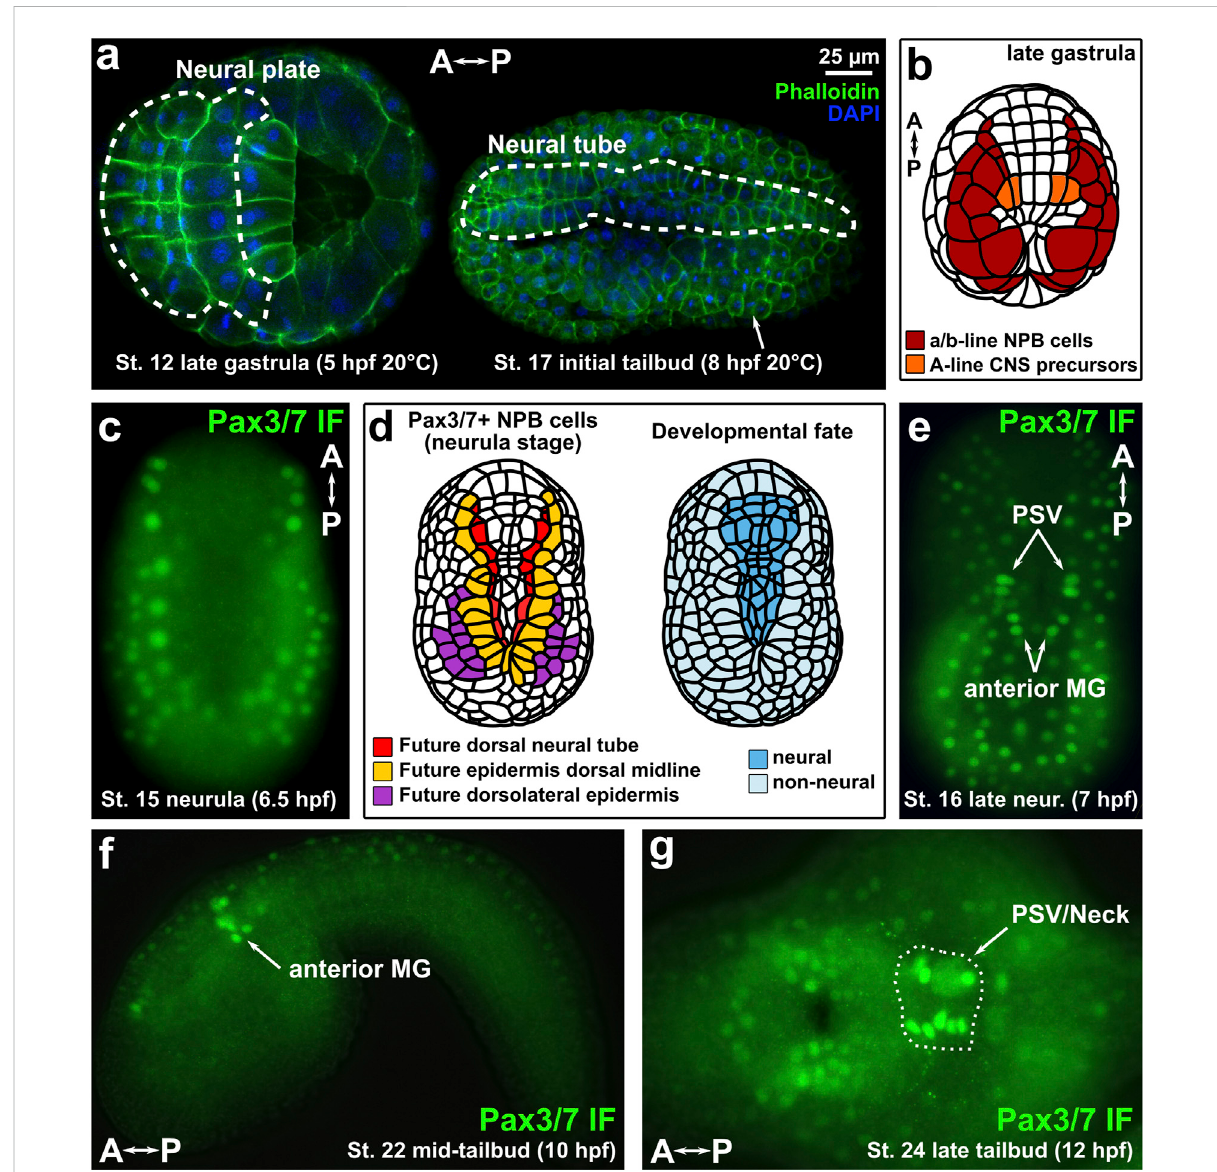
Immuno fl uorescenceofPax3/7inCionaembryos. (A) Cionarobusta(intestinalistypeA)embryosshowingneuralplateandneuraltubecells. (B) Diagram of late gastrula Ciona embryo showing Pax3/7-expressing territories examined in this study. NPB: Neural Plate Borders. CNS: Central Nervous System. (C) Immuno fl uorescence (IF) of Pax3/7 (DP312 antibody) showing expression in lateral borders of the neural plate. (D) Diagram of Pax3/7 + cells in the neural plate borders, indicating their ultimate contribution tothree different dorsal derivatives of the neural/non-neural boundary region of the ectoderm: dorsal neural tube, dorsal midline epidermis, and dorsolateral epidermis. (E) IF of Pax3/7 at the late neurula/initial tailbud stage in which speci fi c Motor Ganglion (MG) and Posterior Sensory Vesicle (PSV) neural progenitors are labelled by anti-Pax3/ 7DP312 antibody. (F) IFof Pax3/7 intheanteriorMG ofthe mid-tailbud embryo. (G) IF ofPax3/7 atlate tailbud stage, showing expression in thebrain and “ Neck ” regions of the CNS (circled by dashed line). A – P: anterior-posterior